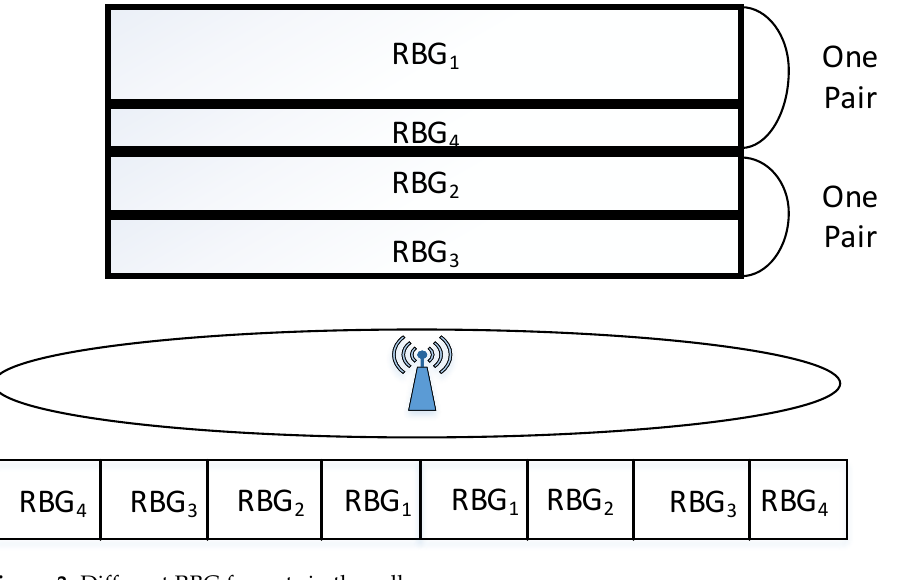
Figure 3. Different RBG formats in the cell. Algorithm 2 Dynamic resource allocation PF algorithm with location and